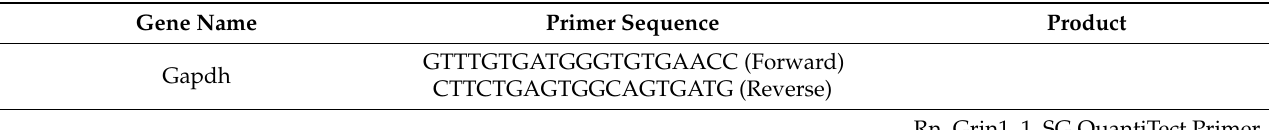
Table 1. Primers employed in qRT-PCR